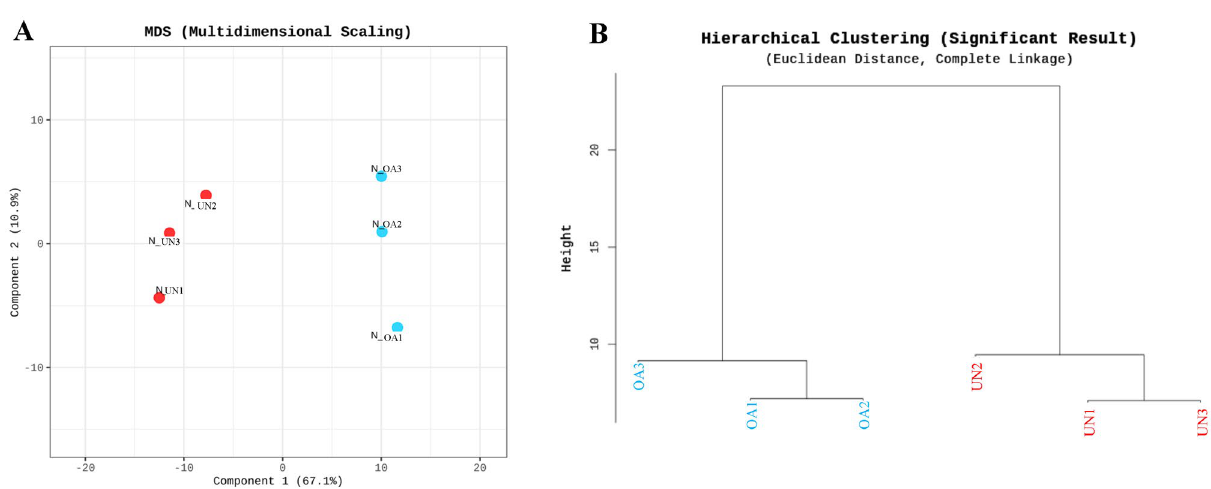
Figure 1. Summary of small RNA composition. UN, unaffected group; OA, osteoarthritis group.